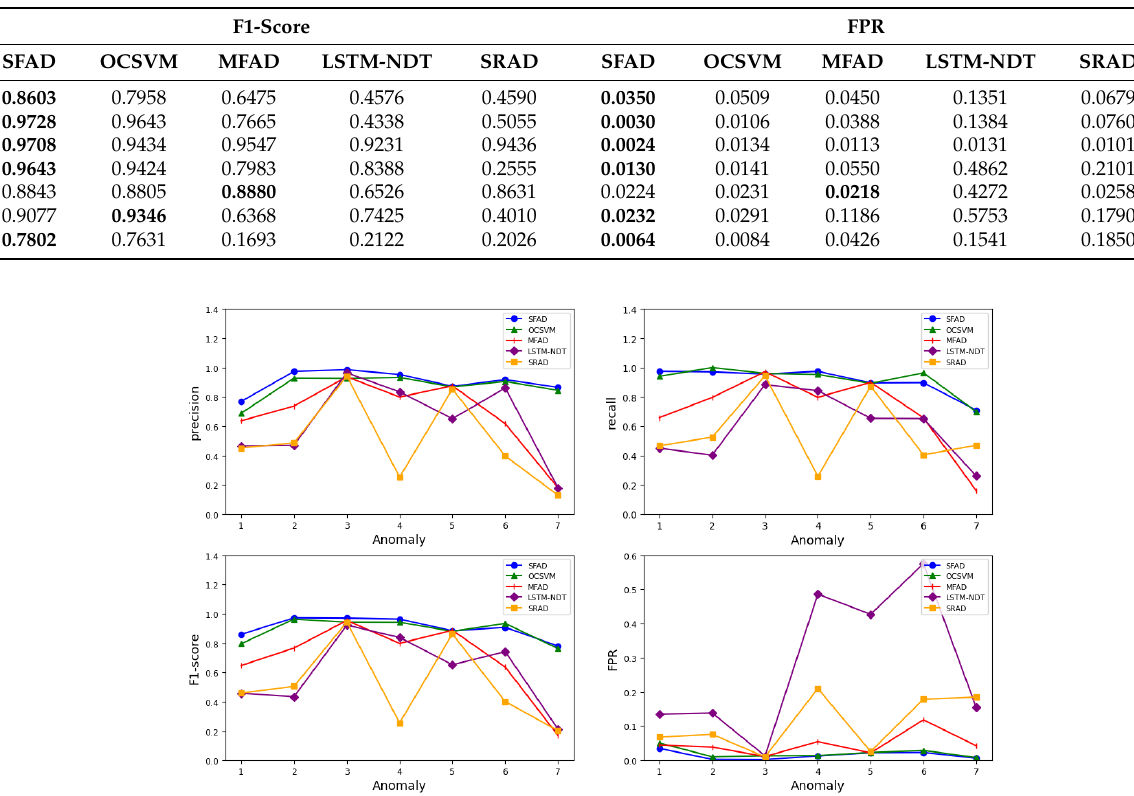
Table 3. F1-score and FPR comparison of anomaly detection.